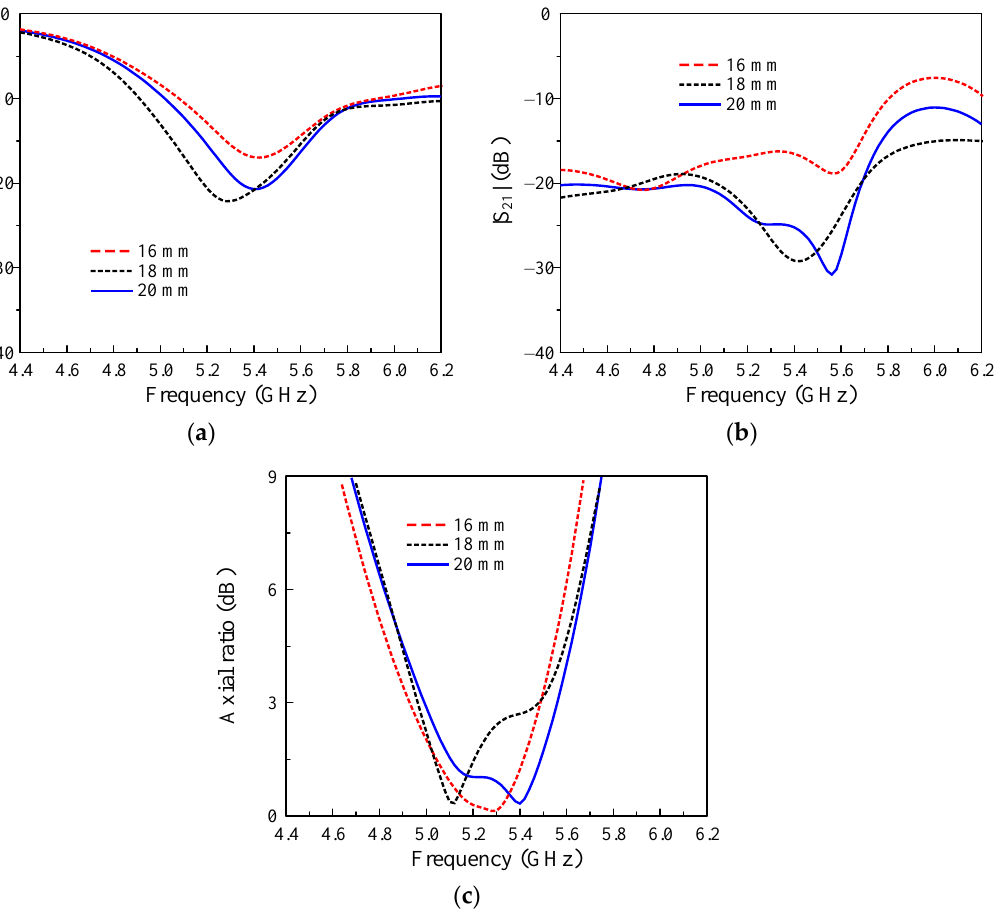
Figure 10. Simulated performance of the proposed MIMO antenna with different values of d 1 . ( a ) Reflection coefficient (|S 11 |), ( b ) transmission coefficient (|S 21 |), and ( c ) axial ratio (AR).